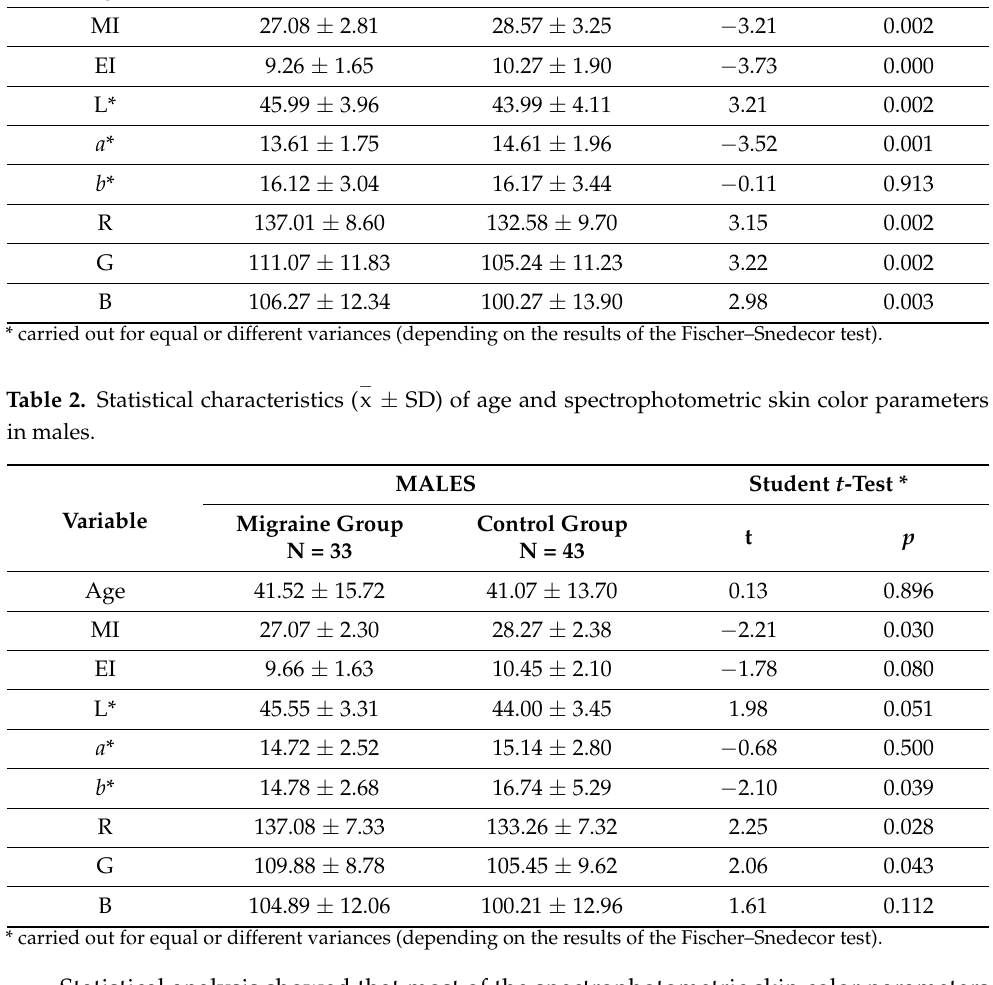
− x ± SD) of age and spectrophotometric skin color parameters